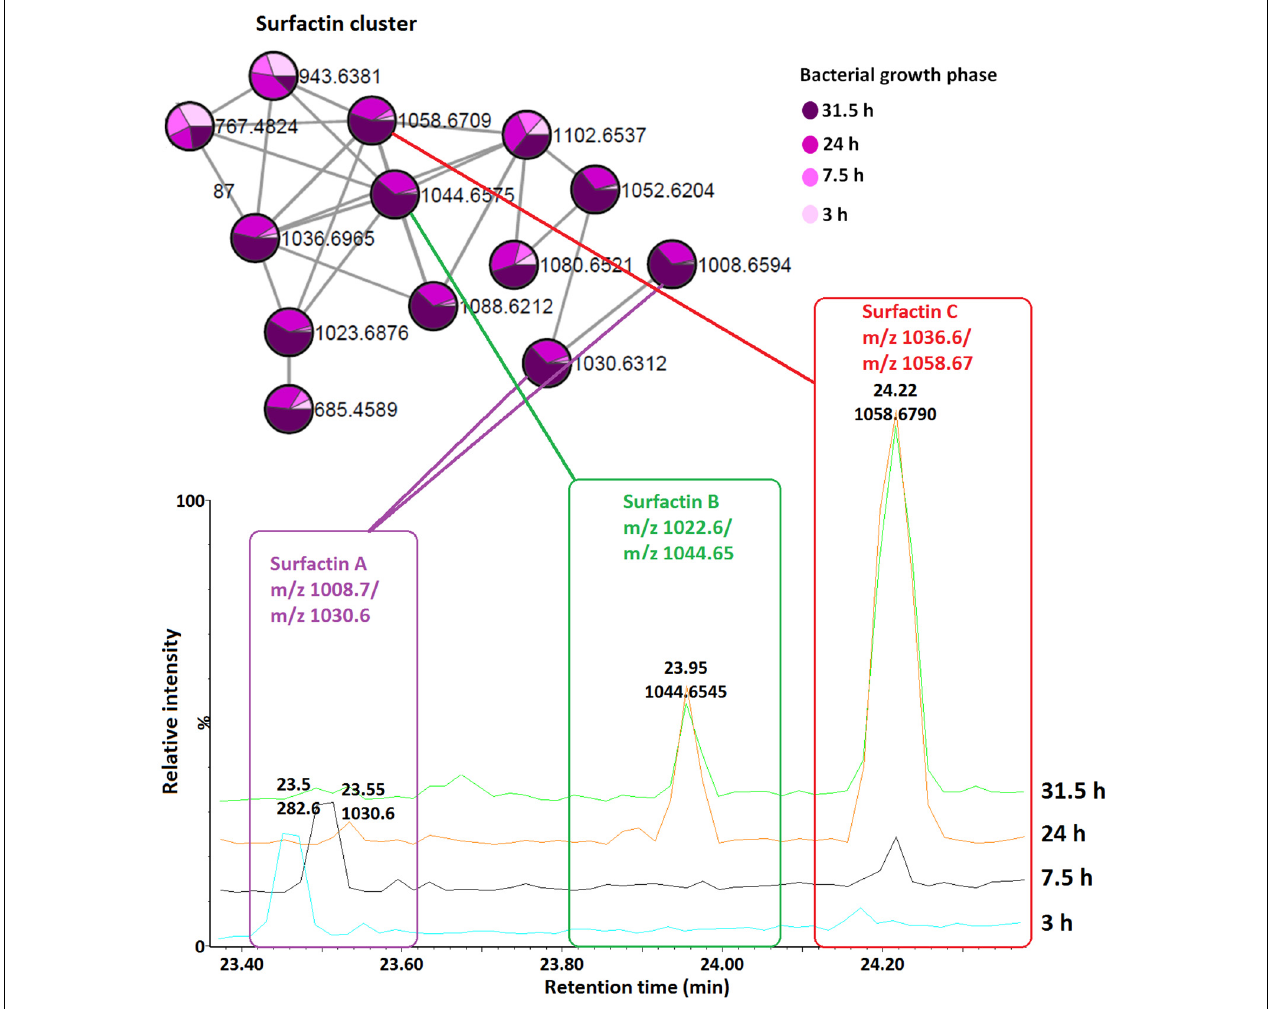
FIGURE 6 | Qualitative and relative quantification of surfactins in the consortium over time (bacterial growth phases). Surfactin A, B, and C are present in large amounts in the late growth stages (24 and 31.5 h, stationary phase) compared to the early growth stages (lag, 3 h and log, 7.5